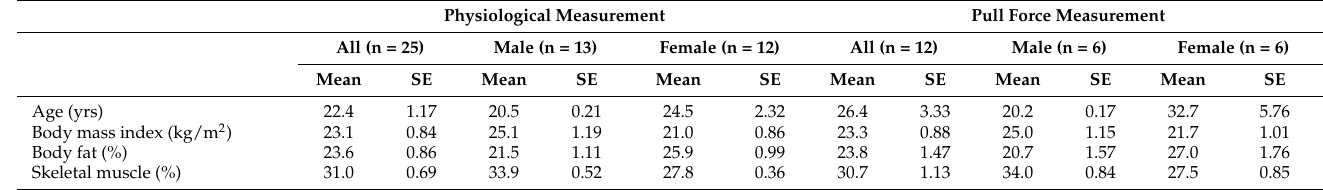
Table 1. Participant